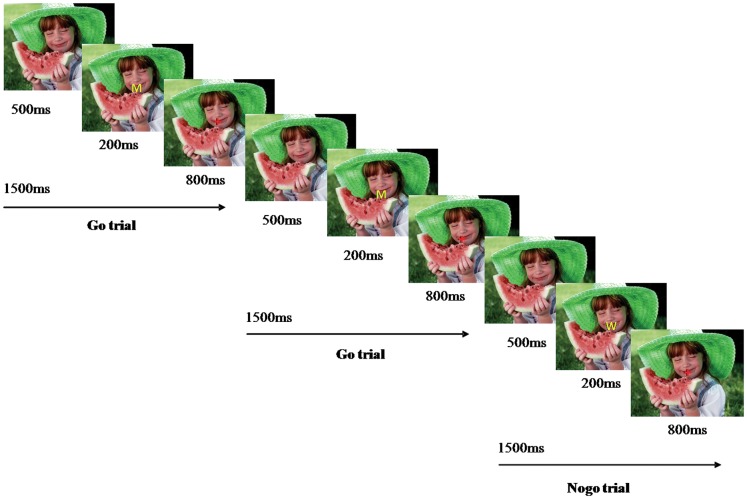
Examples of Go and Nogo trials in a positive context block.